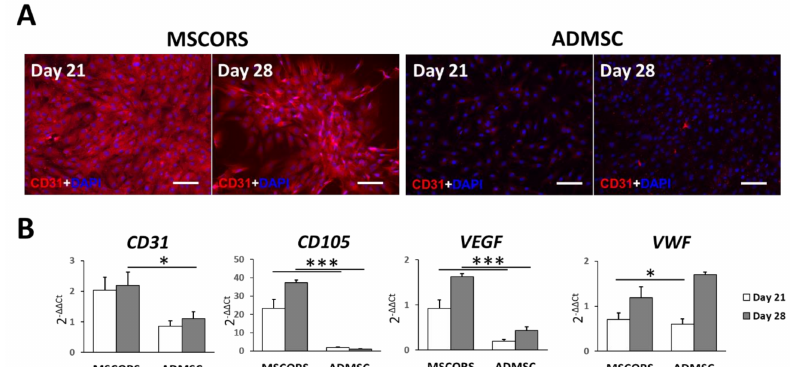
Figure 1. Endothelial differentiation of mesenchymal stem cells from the outer root sheath (MSCORS) and adipose-derived mesenchymal stem cells (ADMSC) in vitro. ADMSC and MSCORS were induced in vitro towards endothelial lineage for 21 and 28 days, and differentiation was evaluated by the means of immunostaining and qRT-PCR. ( A ) CD31 immunostaining on ADMSC and MSCORS (scale bar: 100 µ m; magnification 20 × ). ( B ) Gene expression of endothelial markers in ADMSC and MSCORS during endothelial differentiation. Expression levels were normalized to the housekeeping gene HTRP-1 and calculated using 2 - ∆∆ Ct method against undifferentiated controls of ADMSC and MSCORS. Results are shown as mean ± SD. (* p < 0.05, *** p <